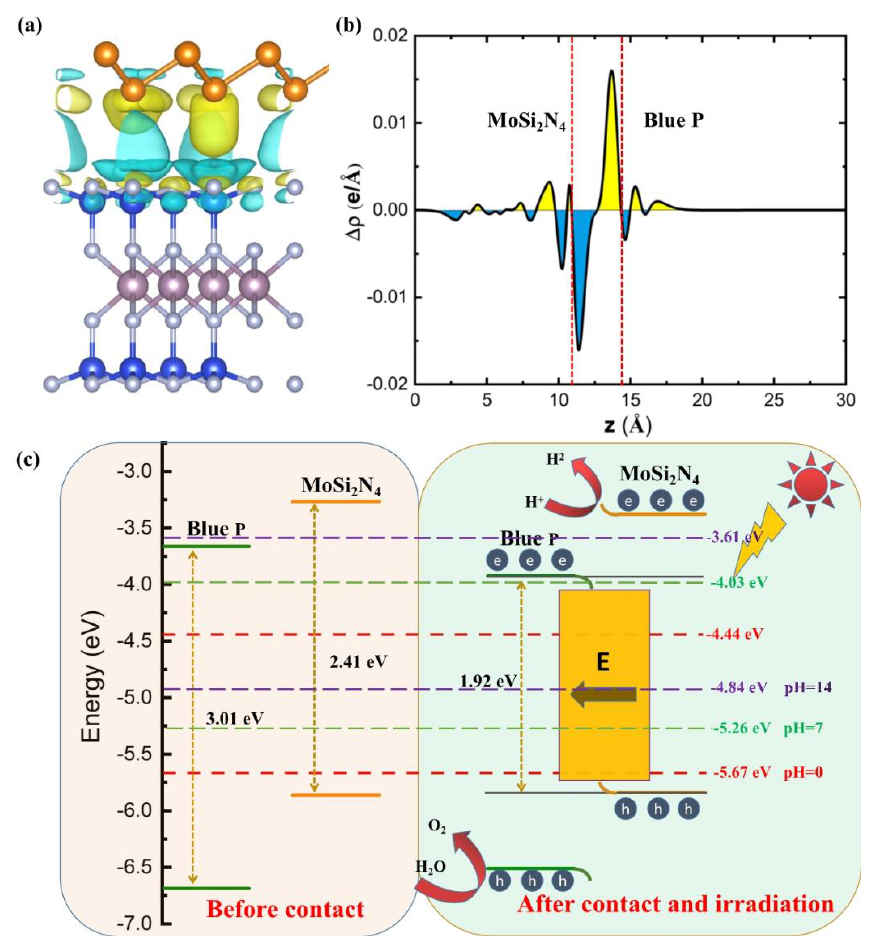
Figure 4. ( a ) Charge density difference (isosurface level: 0.0000745 e /a 03 ), ( b ) planar-averaged charge density difference along the z-axis, and ( c ) photocatalytic mechanism for the Blue P / MoSi 2 N 4 vdWH.